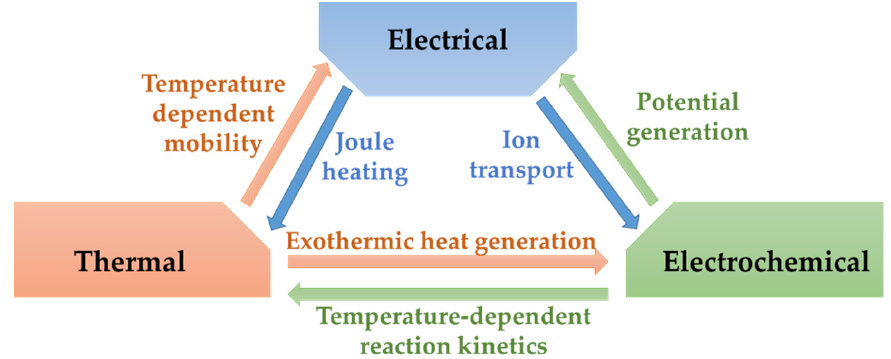
Figure 1. Schematic illustrating processes inside Li-ion batteries. The elementary components of Li-ion batteries are the two electrodes, anode and cathode, and the electrolyte which allows the transfer of lithium ions between the electrodes. The negative electrode (anode) is usually made from carbon (graphite) or lithium titanate (Li 4 Ti 5 O 12 ), while other materials such as Li metals or Li(Si) alloys are considered. The electrolyte is typically an organic liquid containing a variety of organic carbonates and a salt, such as lithium hexafluorophosphate (LiPF6) [13]. Within the family of Li-ion batteries, there are several positive electrode (cathode) materials, which define the battery chemistry, for example: LiCoO 2 (LCO), LiFePO 4 (LFP), Li(Ni 1 − x − y Mn x Co y )O 2 (NMC), Li(Ni 1 − x − y Co x Al y )O 2 (NCA) and LiMn 2 O 4 (LMO) [14]. LCO batteries have high energy density but